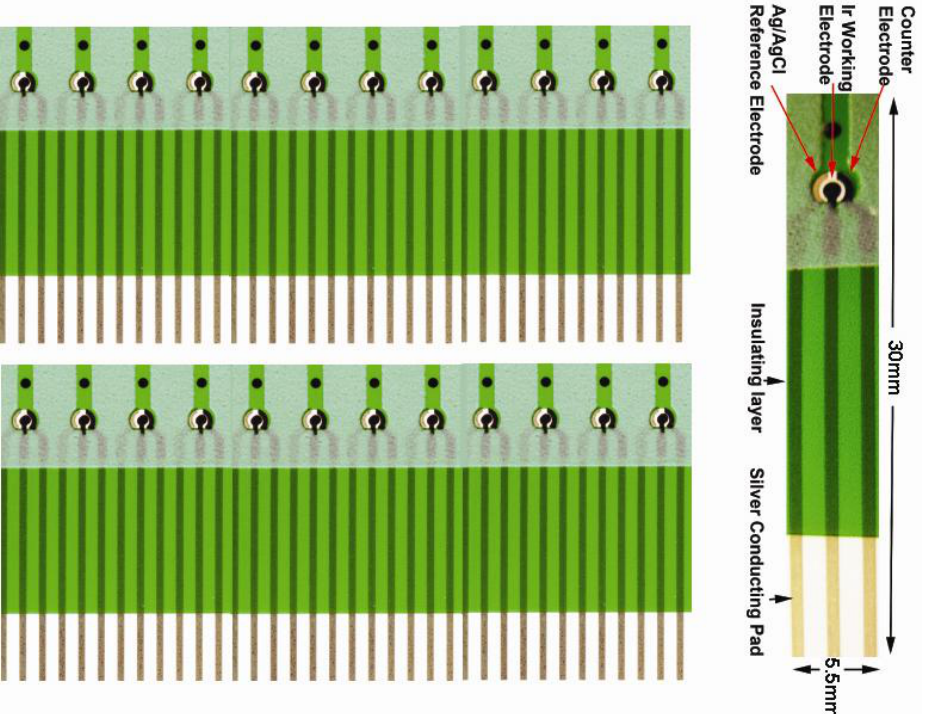
Figure 2. Screen-printed single-use, disposable Ir nano-catalyst contained H biosensor